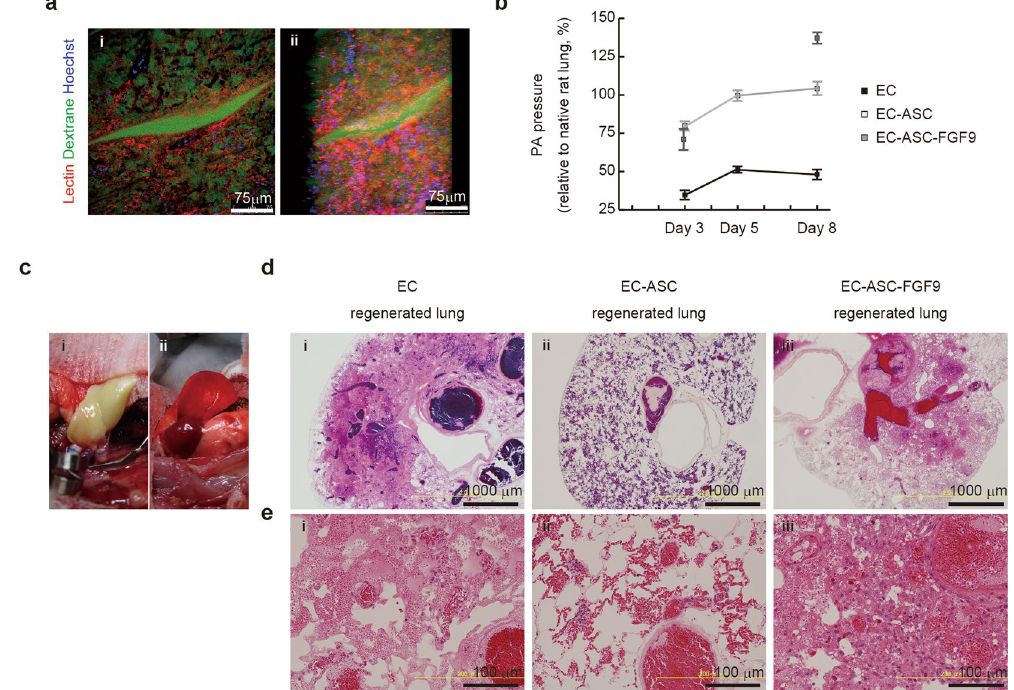
Figure 7. ASC–EC interaction induces development of a vascular network with physiological PA pressure, suppressing lung edema and alveolar hemorrhage of regenerated lungs in vivo . ( a ) Multi-photon excitation microscopy images (i) and 3D reconstruction (ii) of EC–ASC regenerated lungs (day 8 of culture) showing the lectin-labeled pulmonary capillary network (red) in the FITC-dextran-labeled lung matrix (green). When seeded with ASCs, ECs assembled into a capillary network, representing native lung parenchyma. ( b ) Line chart summarizing sequential PA pressures of regenerated lungs under constant rate perfusion (4 mL/min) at days 3, 5, and 8 (normalized to native rat lung pressure). ( c ) Orthotopic transplantation of EC–ASC-regenerated lungs. Representative pictures showing a regenerated lung graft after anastomosis of the pulmonary artery, pulmonary vein, and bronchus before (i) and after re-perfusion (ii). All engineered lungs were perfused with blood over a period of seconds to minutes. ( d, e ) Corresponding H&E-stained low- ( d , x4) and high-magnification ( e , x20) views of thin sections from regenerated lungs (i–iii) 3 h after transplantation. In the EC group, exudative fluid leaked into the alveolar space, representing lung edema. In the EC–ASC group, fluid leakage was suppressed and red blood cells were retained in the lung vessels and alveolar capillaries. In the EC–ASC–FGF9 group, regenerated cells grew into the vascular space obstructing the blood supply. All values are means ± SD of three independent